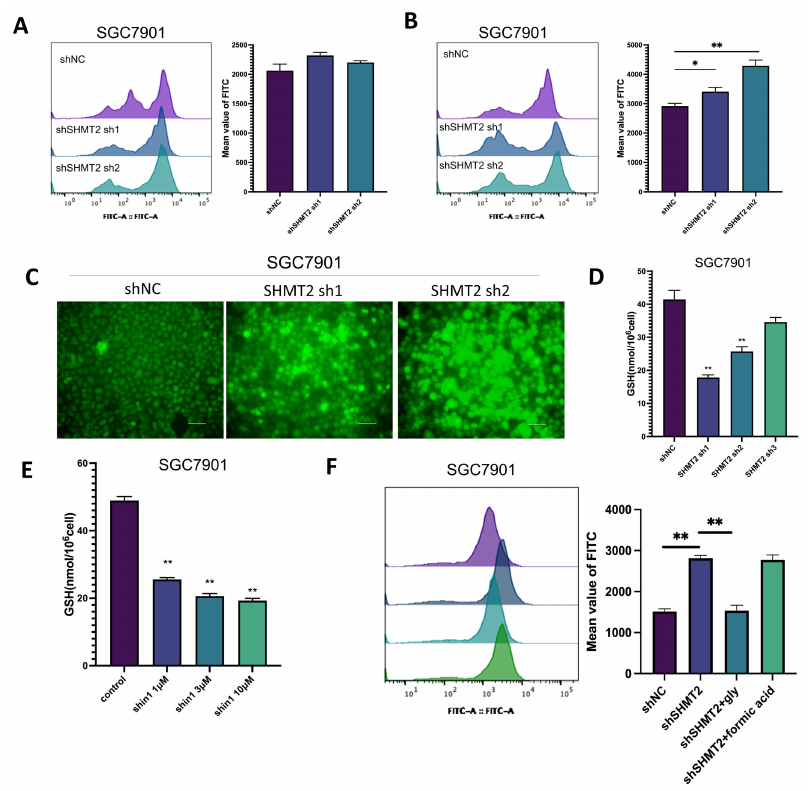
Figure 5. SHMT2 promoted the growth of GC cells by maintaining the redox balance in GC cells under hypoxia. ( A ) Effect of SHMT2 knockdown on ROS levels in SGC7901 cells under normoxic conditions. ( B ) Effect of SHMT2 knockdown on ROS levels in SGC7901 cells under hypoxia